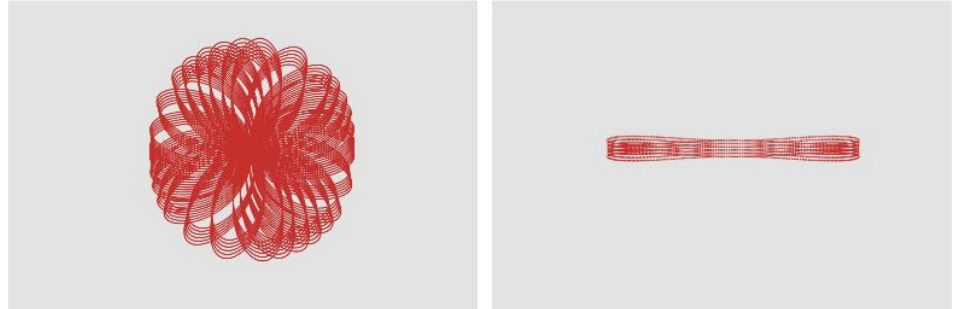
Figure 3. Non-repetitive petal scanning ( left ) and repetitive line scanning ( right ) of DJI Zenmuse L1 Livox LiDAR module.